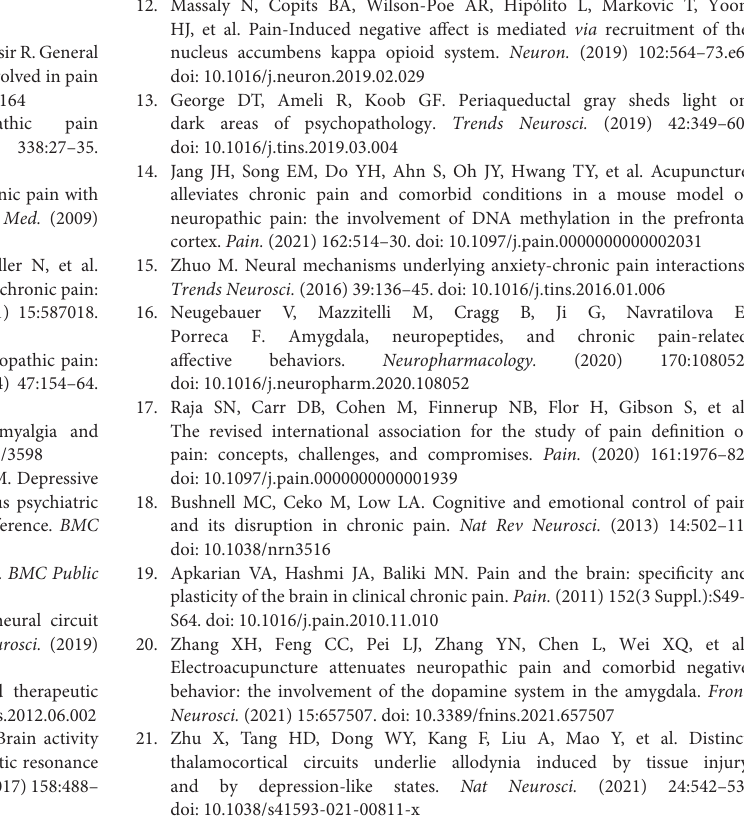
Supplementary Figure 1 | (A) The ALFF values in the left mPFC (32 days post-CCI surgery) negatively correlated with MWT values (28 days post-CCI surgery); (B–E) No significant correlations were observed between ALFF values in the left somatosensory cortex and mPFC (32 days after CCI surgery) and distance traveled and time spent in open arms on EPMT (29 days post-CCI surgery) (all p > 0.05). Supplementary Figure 2 | No significant correlations were observed between DC values in the right motor cortex (32 days post-CCI surgery) and distance traveled (A) and time spent (B) in the open arms on EPMT (29 days post-CCI surgery) (all p >